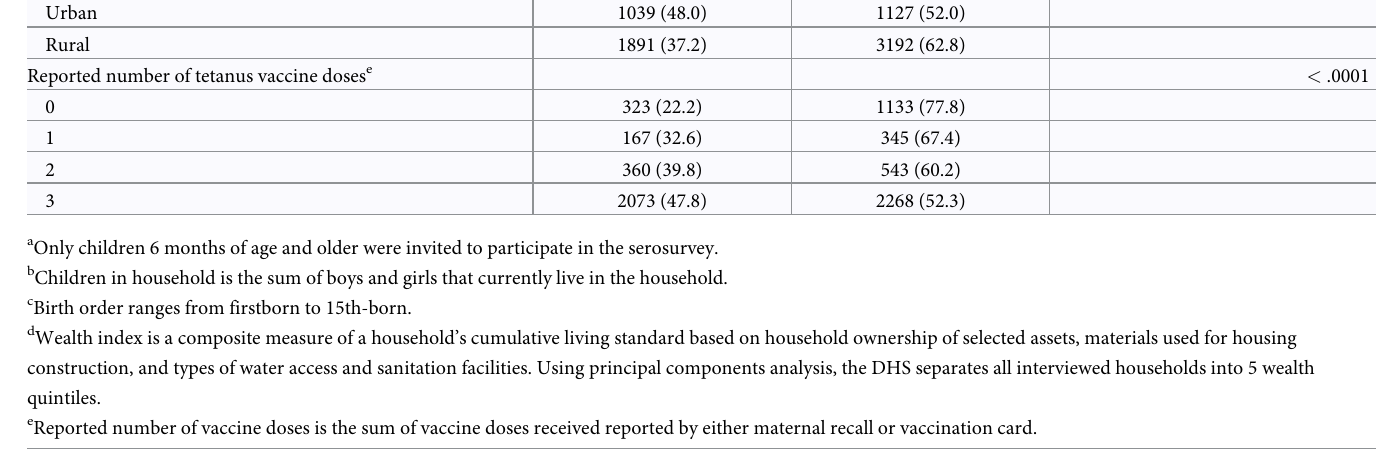
in the household compared to only one child. The odds of seroprotection were positively asso- ciated with wealth index, specifically in the middle and richest areas compared to poorest, and were higher in most provinces compared to Bandundu, especially Nord-Kivu, but was lower among children in Katanga (Fig 5).